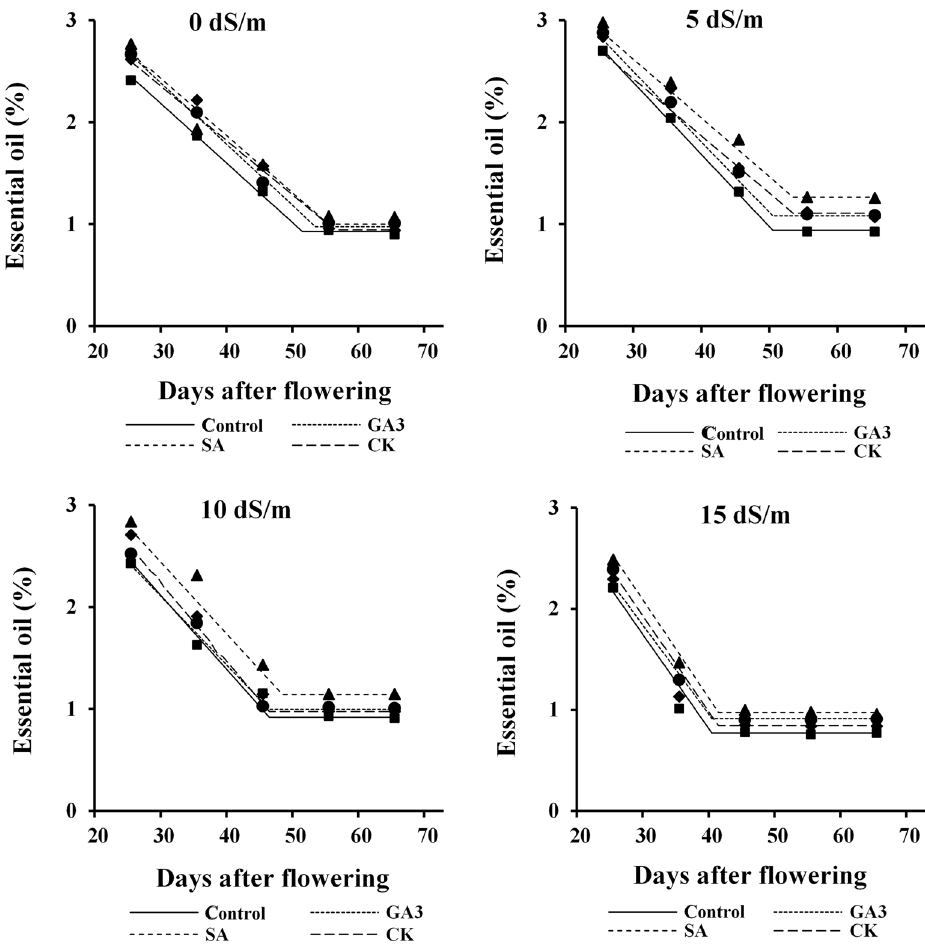
Figure 3. Changes in essential oil percentage during dill seed development in response to salinity and hormonal treatments. GA 3 , SA, CK gibberellic acid, salicylic acid and cytokinin,